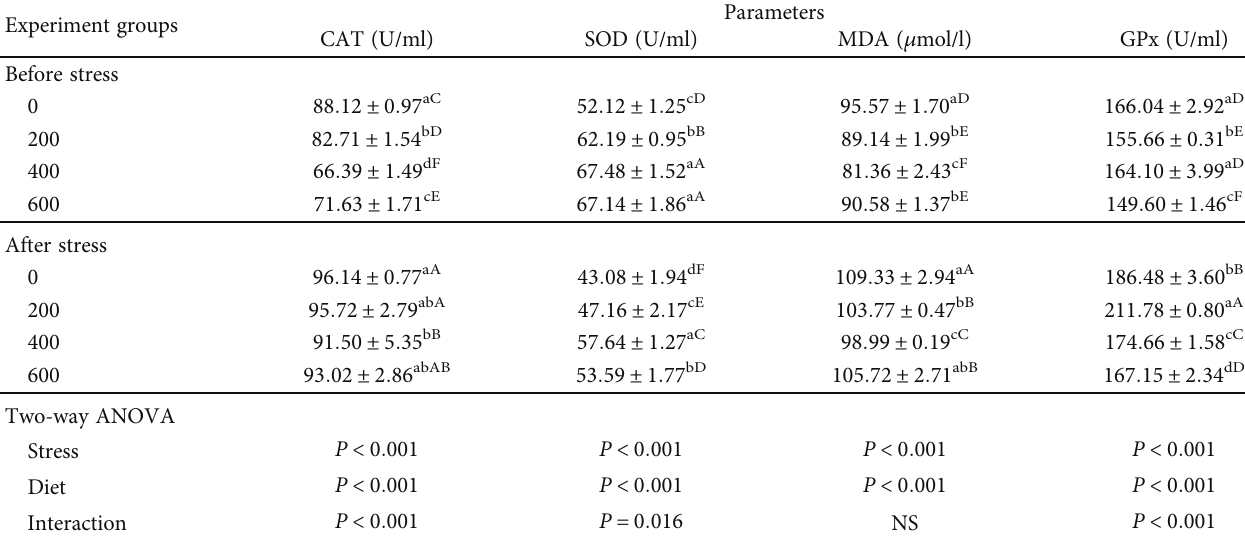
Table 5: Antioxidant enzymes of common carp fed di ff erent levels of quercetin for 60 days before and after heat stress. Experiment